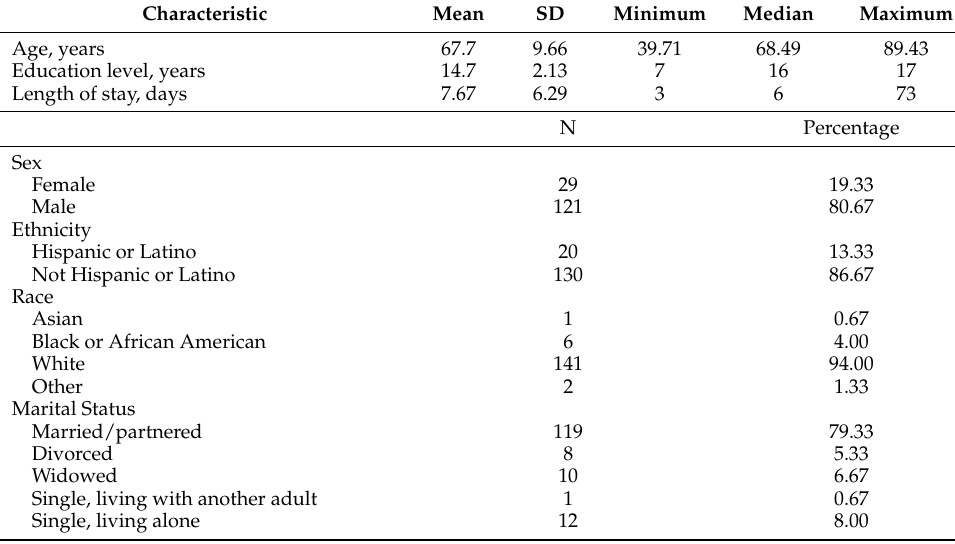
Table 1. Patient and disease characteristics (N =